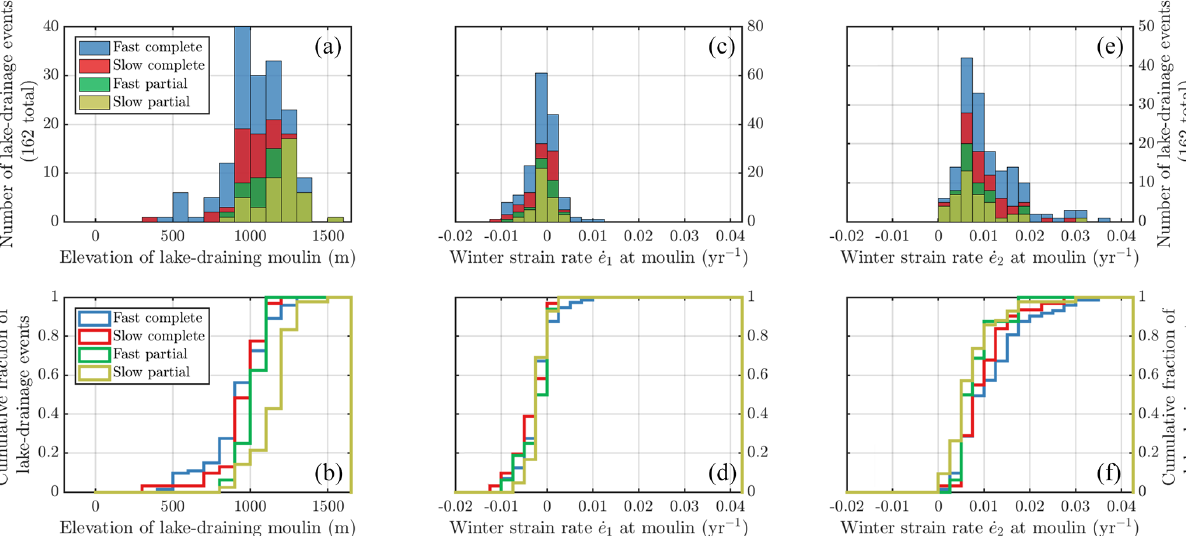
Figure 7. Distributions of elevation and strain rates at the locations of moulins associated with 78 draining supraglacial lakes, classified by drainage type of the lake (fast or slow) and the completeness of the lake drainage (complete or partial), following Chudley et al. (2019). Moulins were located each year using WorldView imagery, when possible; when imagery was not available or when the lake did not drain, the moulin location was set to the center of the lake basin. (a) Histogram of elevations of the moulins associated with N = 162 lake drainage events over the 19 melt seasons from 2006–2010 and 2013–2018 whose type and completeness were observed with high confidence. (b) Cu- mulative distribution of the elevations of these moulins, separated by lake drainage type and completeness. (c) Background more compres- sional strain rate, ˙ (cid:15) 1 , observed the preceding winter for each lake-draining moulin. (d) Cumulative distribution of ˙ (cid:15) 1 , by lake drainage type and completeness. (e) Background more extensional strain rate, ˙ (cid:15) 2 , observed the preceding winter for each lake-draining moulin. (f) Cu- mulative distribution of ˙ (cid:15) 2 , by lake drainage type and completeness. Strain rates were calculated with the near-yearly wintertime mosaics, MEaSUREs Greenland Ice Sheet Velocity Map from InSAR Data, Version 2 (Joughin et al., 2018b, 2010), supplemented with ESA Climate Change Initiative in winters 2013 and 2017 (Boncori et al., 2018) when MEaSUREs data are not available, as shown in Fig.